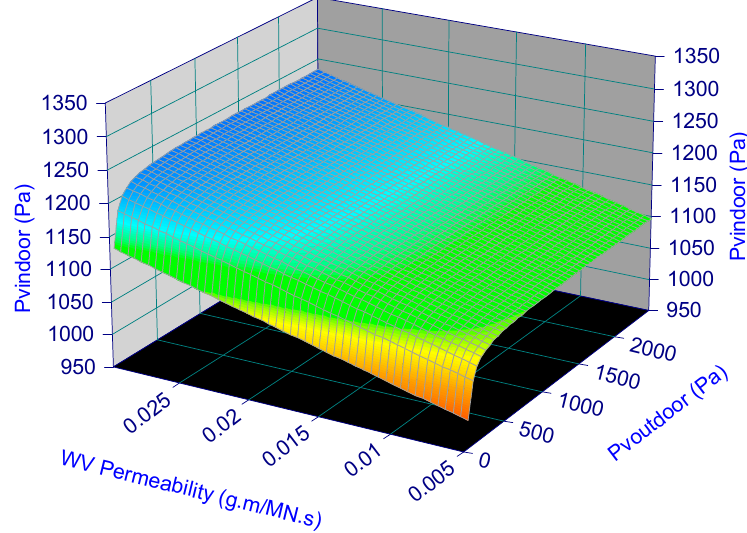
Figure 9. Indoor vapour pressure as a function of outdoor conditions and permeability during the unoccupied period.